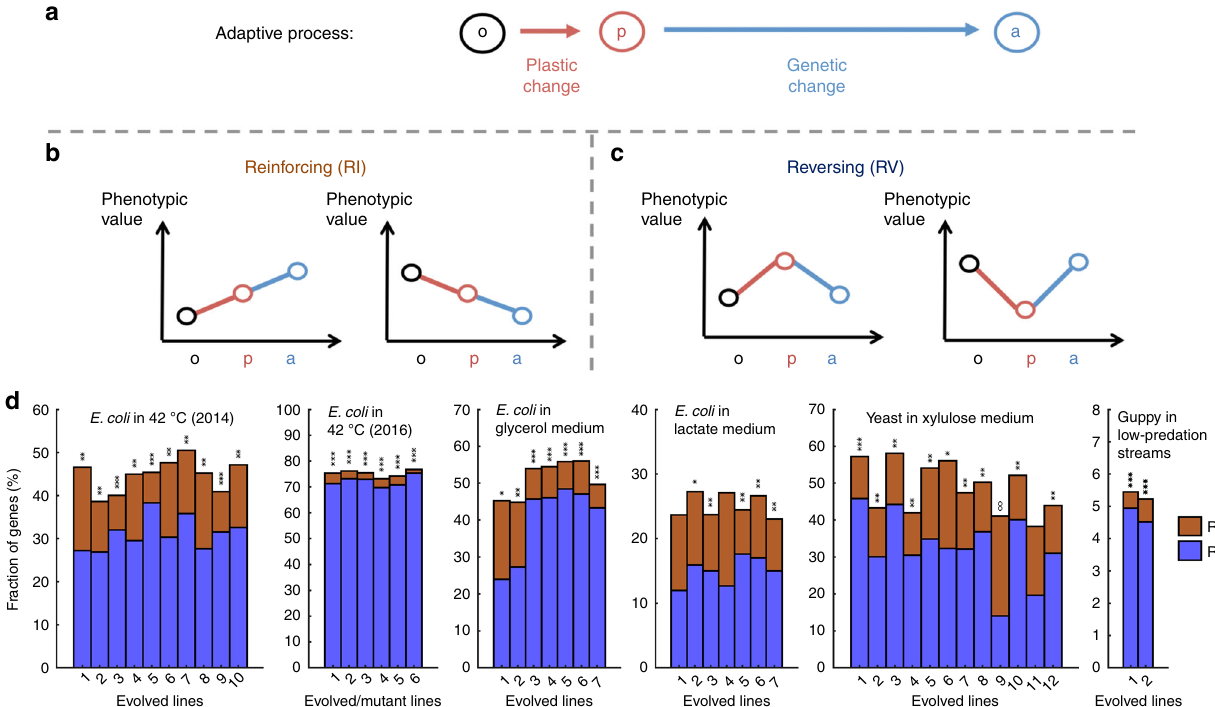
Fig. 1 Gene expression changes in experimental evolution. a Phenotypic adaptation is studied by comparing the phenotypic values of a trait at three stages: ancestral organisms adapted to the original environment measured in the original environment (stage o); ancestral organisms measured in the new environment (stage p); and evolved organisms adapted to the new environment measured in the new environment (stage a). Plastic changes refer to changes from stage o to p, while genetic changes refer to changes from stage p to a. b A pair of plastic and genetic phenotypic changes of a trait are said to be reinforcing if both are larger than a preset cutoff and are in the same direction. c A pair of plastic and genetic phenotypic changes of a trait are said to be reversing if both are larger than a preset cutoff but are in opposite directions. d Fractions of genes with reinforcing ( C RI ) and reversing ( C RV ) expression changes, respectively, in experimental evolution. Organisms as well as the new environments to which the organisms were adapting to are indicated. Each bar represents an adaptation. The equality in the fraction of reinforcing and reversing genes in each adaptation is tested by a two-tailed binomial test. When C RV > C RI , P -values are indicated as follows: * P < 0.05; ** P < 10 − 10 ; *** P < 10 − 100 ; when C RV < C RI , P -values are indicated as follows: o P < 0.05; oo P